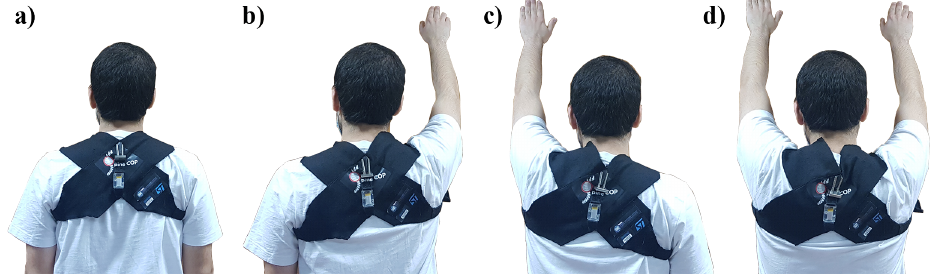
Figure 3. Various calibration positions imposed to the user. ( a ) Both arms down. ( b ) Right arm up. ( c ) Left arm up. ( d ) Both arms